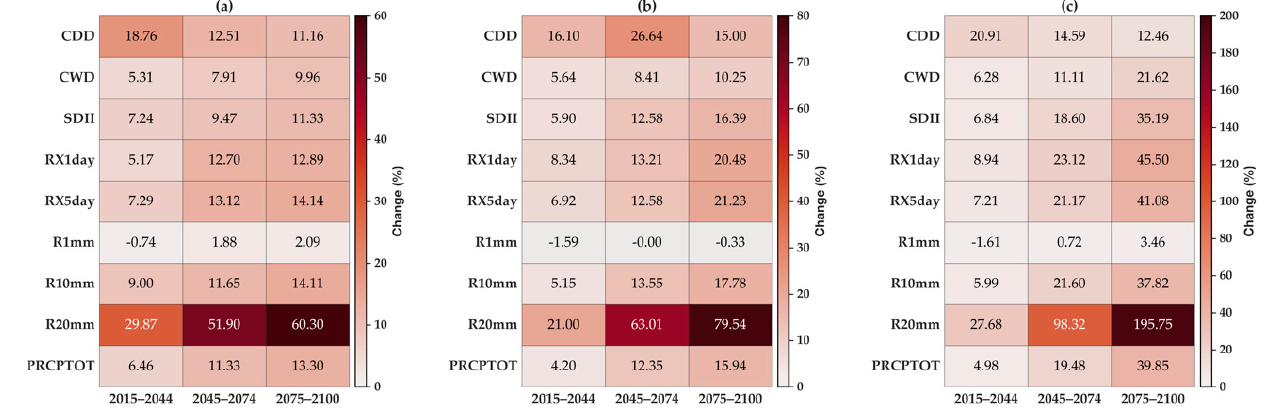
Figure 4. Projected changes [near-future (2015–2044), mid-future (2045–2074), distant-future (2075–2100)] in precipitation extremes under ( a ) SSP1-2.6 ( b ) SSP2-4.5 and ( c ) SSP5-8.5 over GRB. Projected changes in temperature extremes were studied using 14 indices (Figure 5).